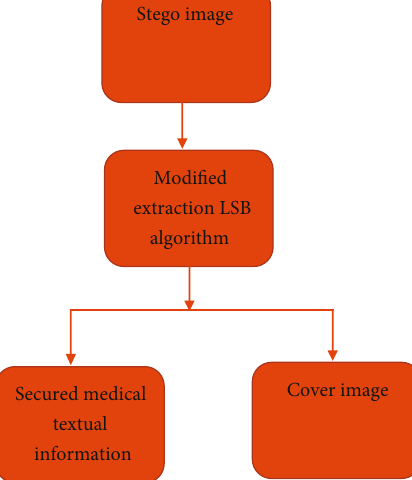
Figure 2: Extraction phase of the projected system.